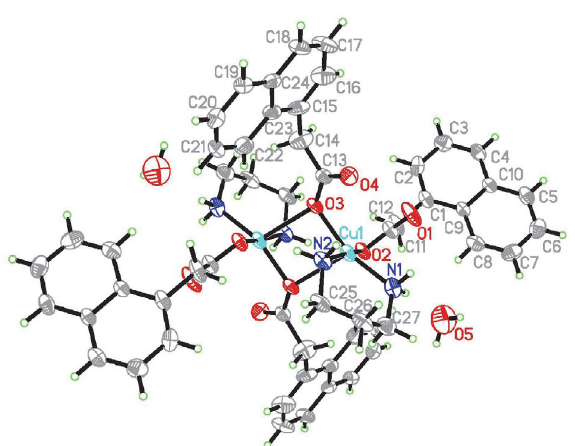
Figure 2. Molecular structure of 2 · 2H 2 O at 30% probability dis- placement.